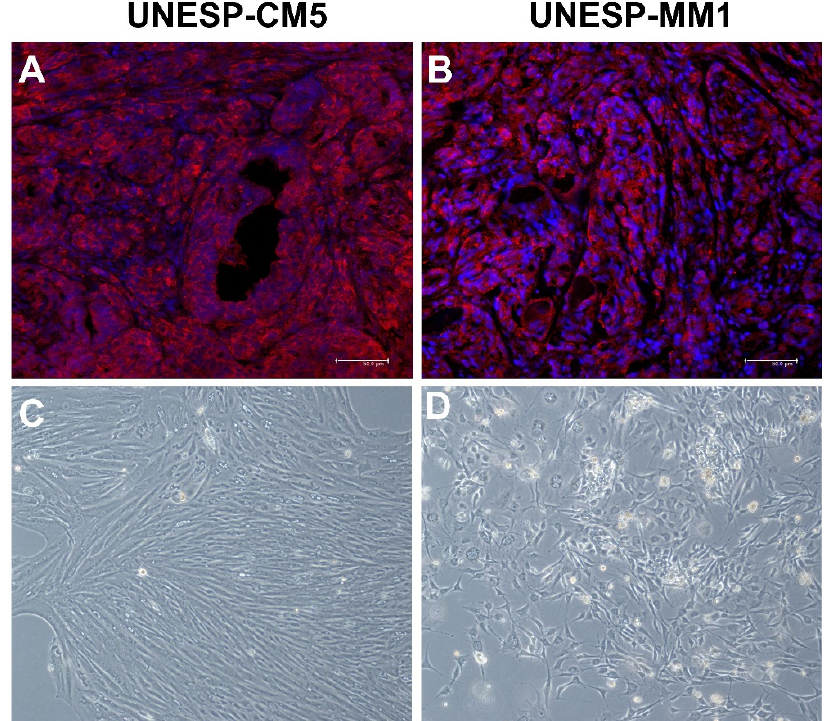
Figure 1. COX-2 expression and morphological characteristics of UNESP-CM5 and UNESP-MM1 from tumor samples and cancer cell lines. ( A ): primary tumor that caused the UNESP-CM5 cancer cell line presenting COX-2 positive immunofluorescence (red color). ( B ): tumor sample that caused UNESP-MM1 cell line presenting COX-2 overexpression (red color) by immunofluorescence. ( C ): fibroblastoid to polygonal morphology of UNESP-CM5 cell line (20x). ( D ): polygonal morphology of UNESP-MM1 cell line (20x).